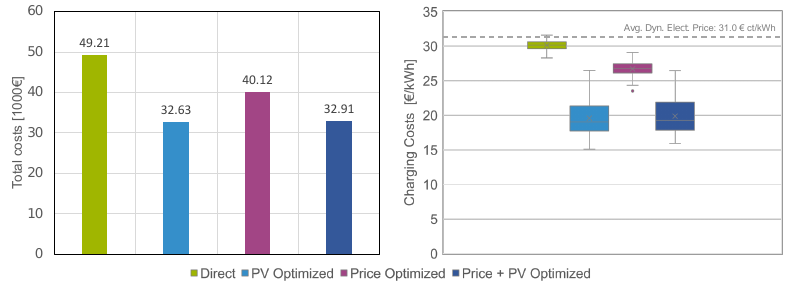
Figure 16. ( Left ): Total charging costs for all charging configurations and the 100 vehicles. ( Right ): Distribution of charging costs for all charging configurations and the 100 vehicles in EUR